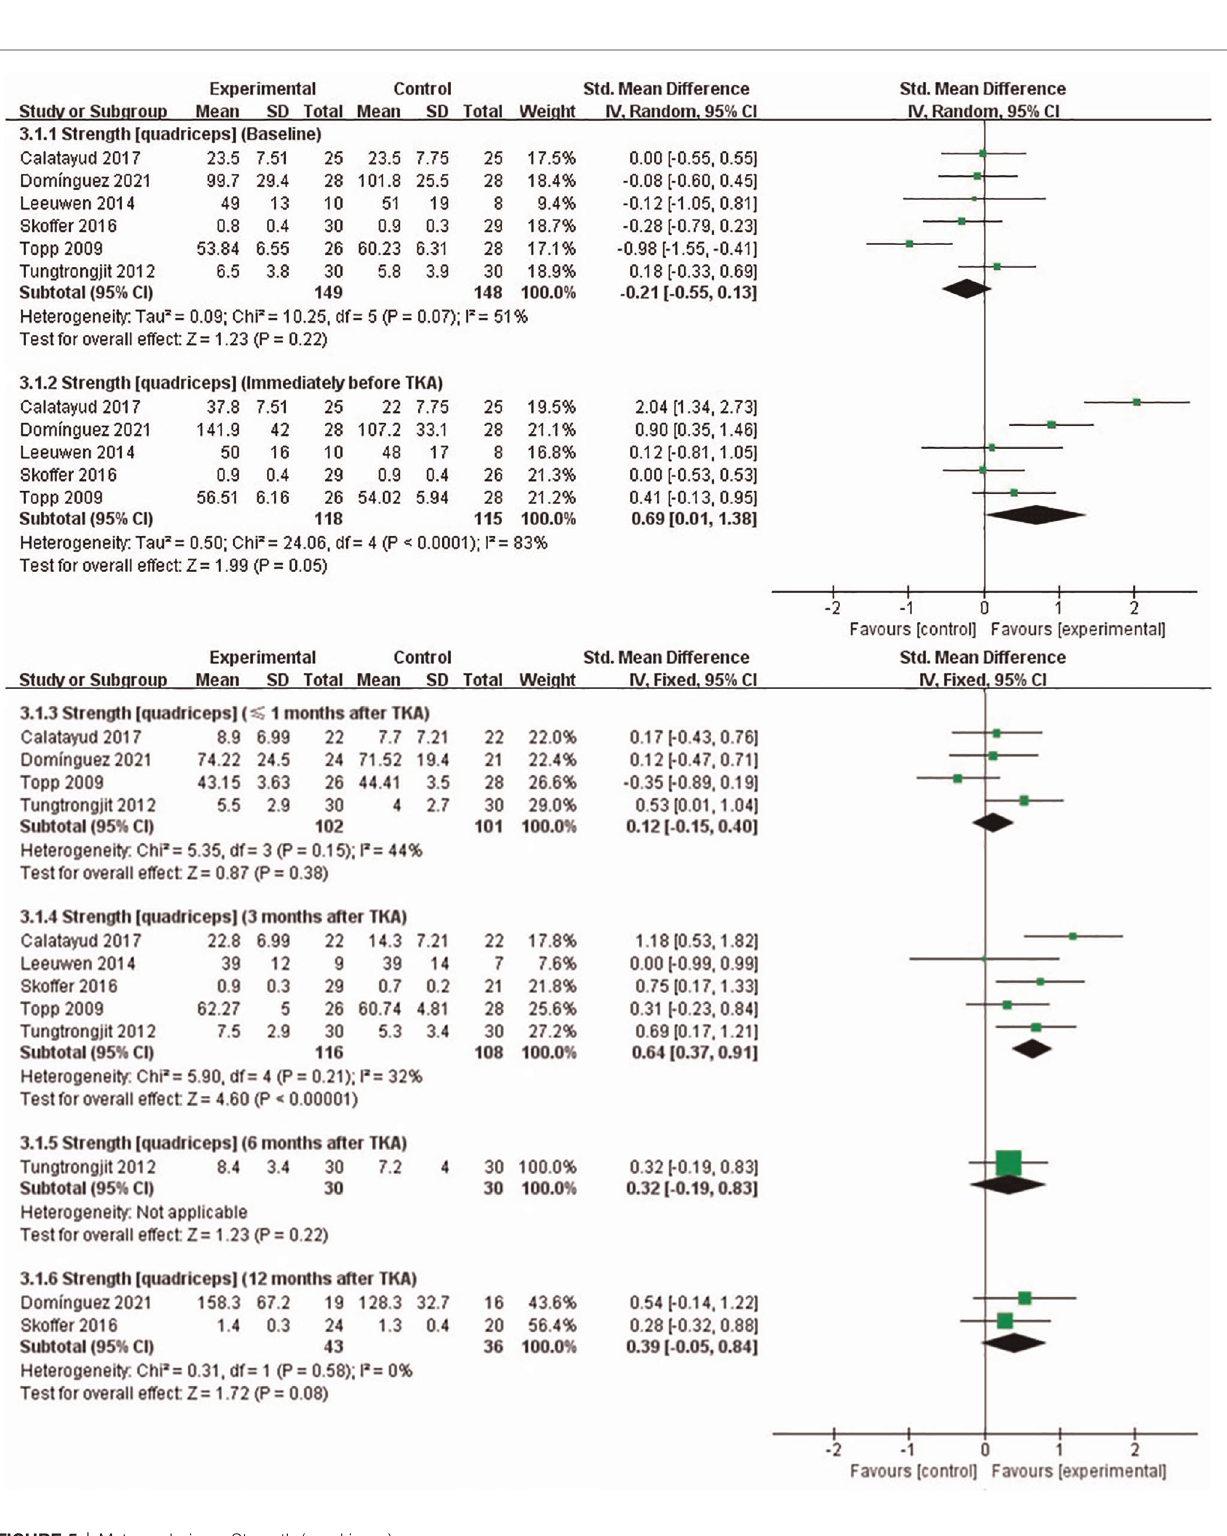
FIGURE 5 | Meta-analysis on Strength